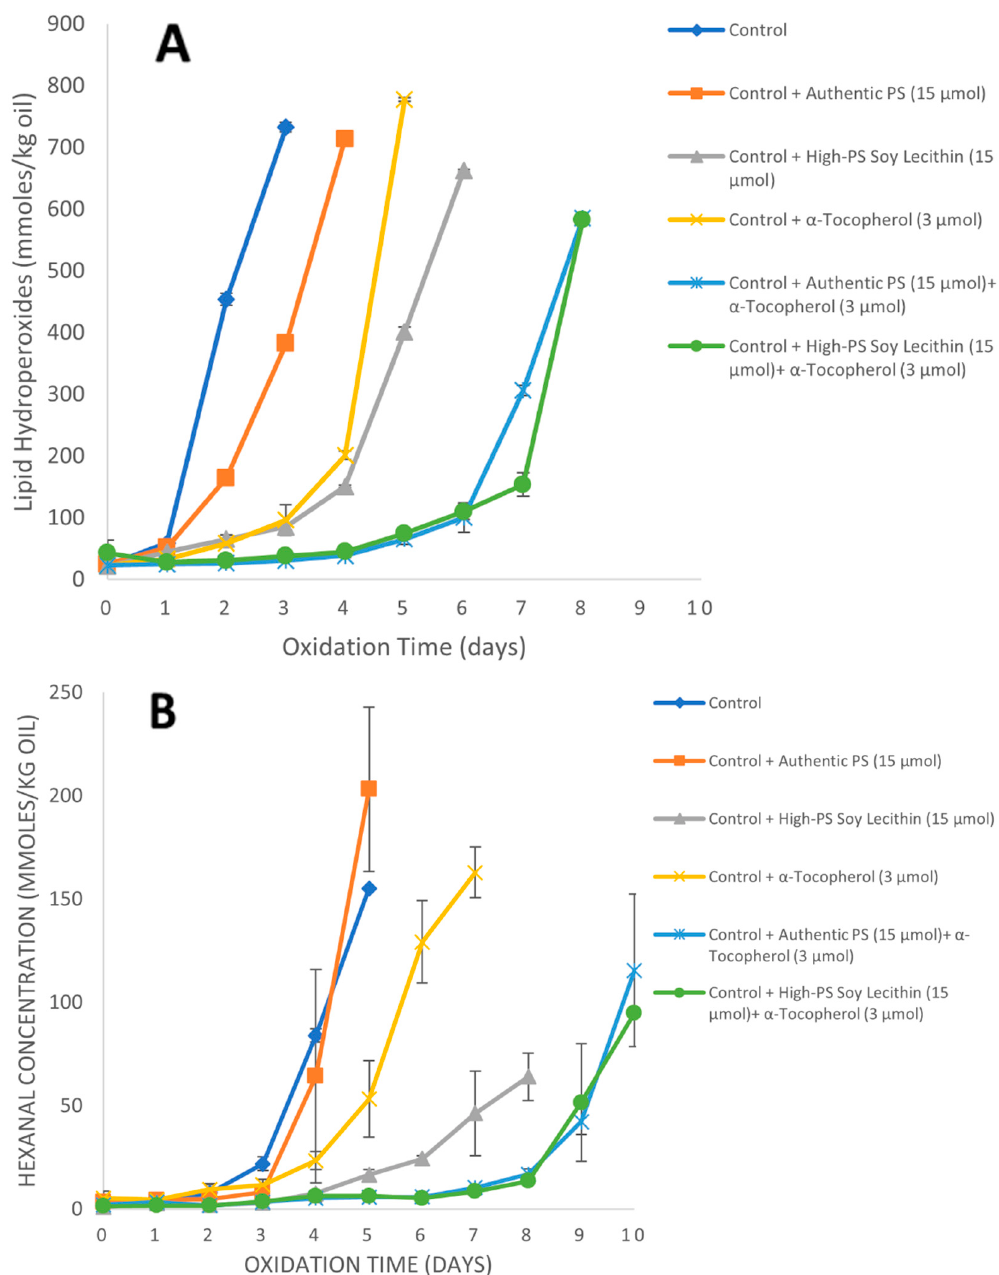
Figure 5. Formation of lipid hydroperoxides ( A ) and hexanal ( B ) in 1% stripped soybean oil-in- in-water emulsions stabilized with Tween 20 containing 3.0 µ mol/kg of α -tocopherol and/or water emulsions stabilized with Tween 20 containing 3.0 µmol/kg of α -tocopherol and/or 15.0 15.0 µ mol/kg of PS or phospholipase-D-modified high-PS soy lecithin at 20 ◦ C. Each value rep- µmol/kg of PS or phospholipase-D-modified high-PS soy lecithin at 20 °C. Each value represents the resents the mean ( n = 3) ± standard deviations. Some error bars lie within the data mean ( n = 3) ± standard deviations. Some error bars lie within the data points.